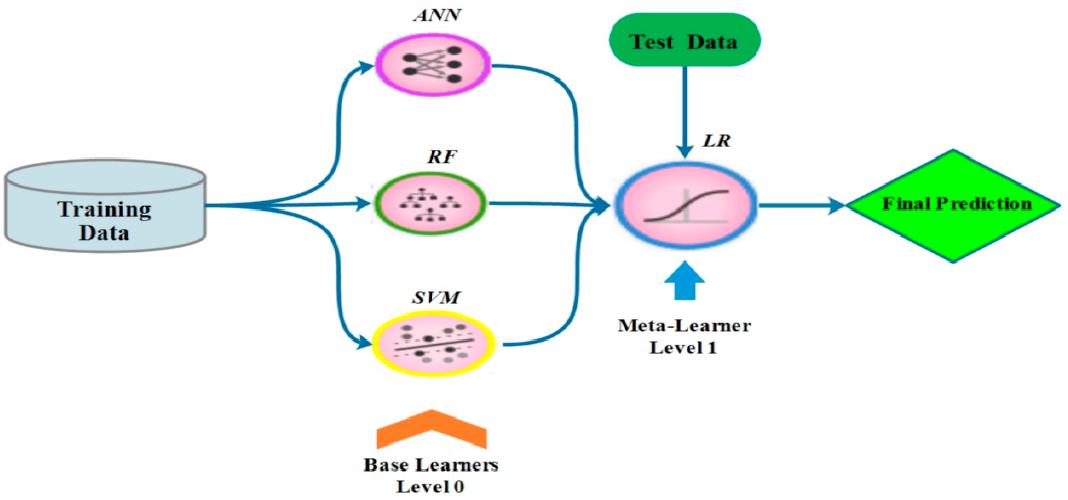
Figure 5. Flowchart of the stacking model.